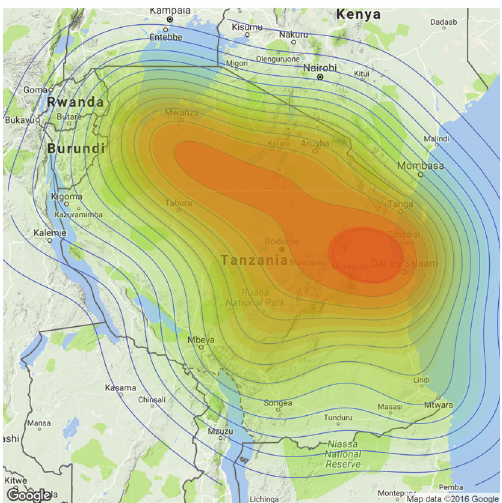
Figure 3: Geographic distribution of colorectal cancer.